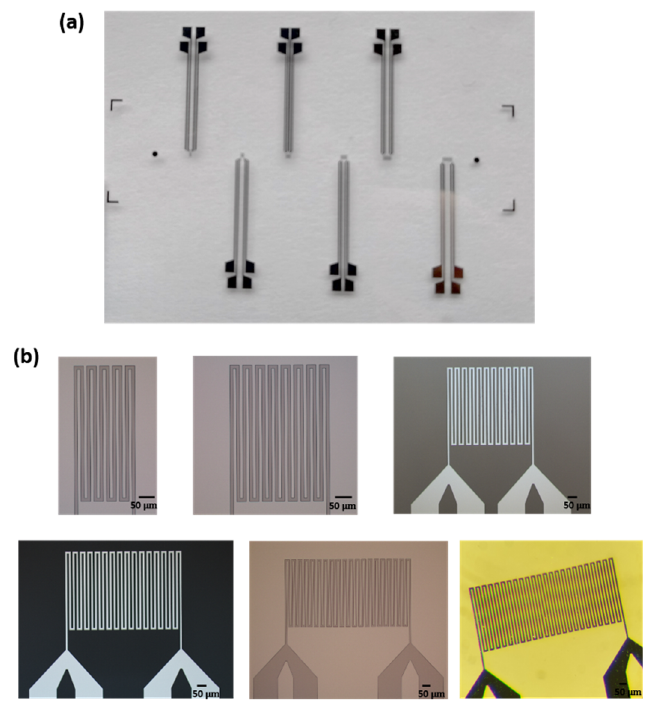
Figure 6. (a ) Photographs of the fabricated temperature microsensors and ( b ) detail of the different windings (line width and spacing of 10 µm).